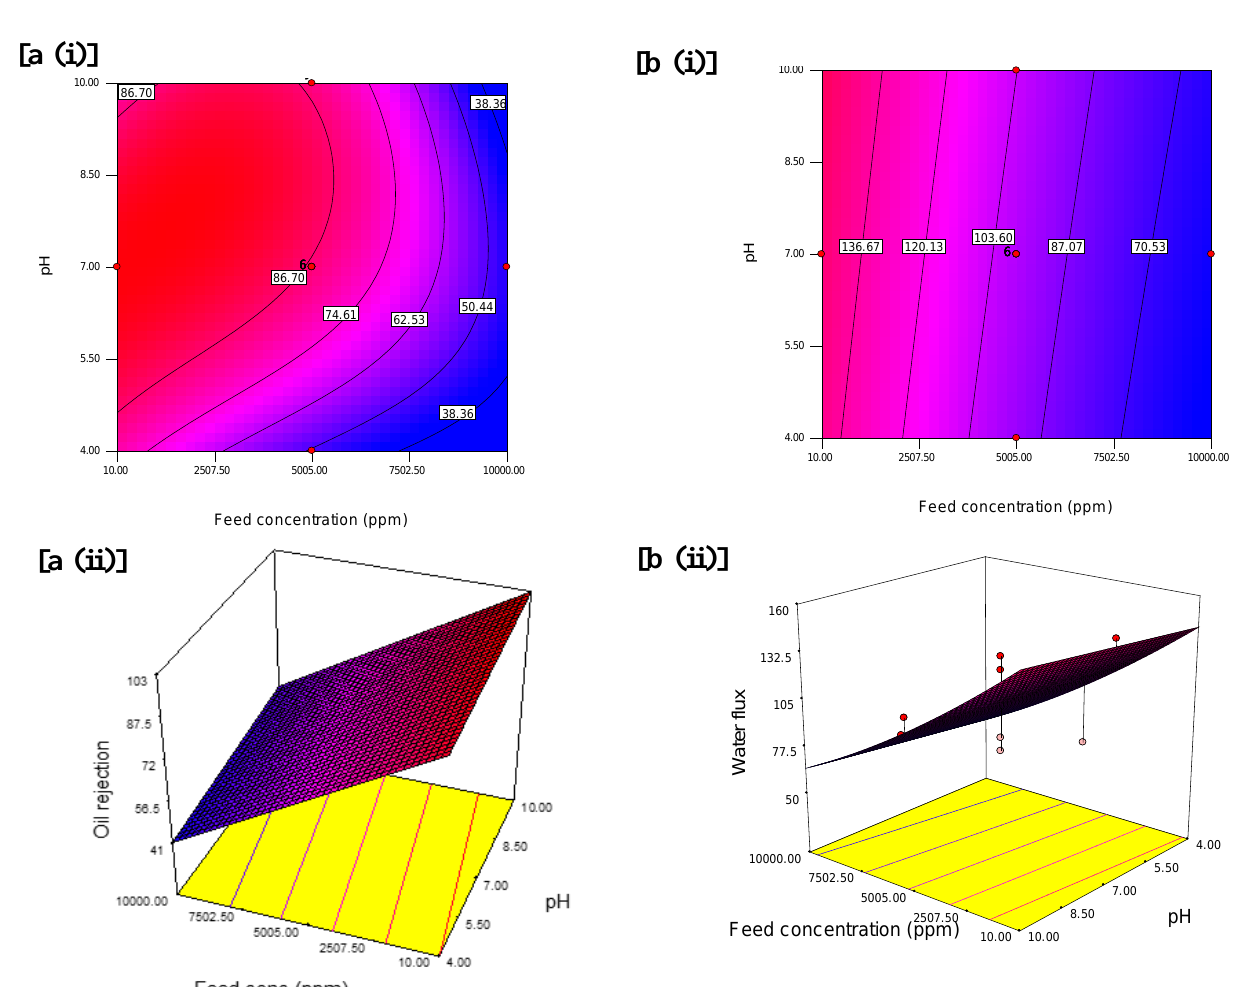
Figure 7. ( i ) Contour plot and ( ii ) 3D surface graph ( a ) for the interaction effect of feed concentration and pH on oil rejection (%) and ( b ) for the interaction effect of feed concentration and pH on water flux (L/m 2 · h).